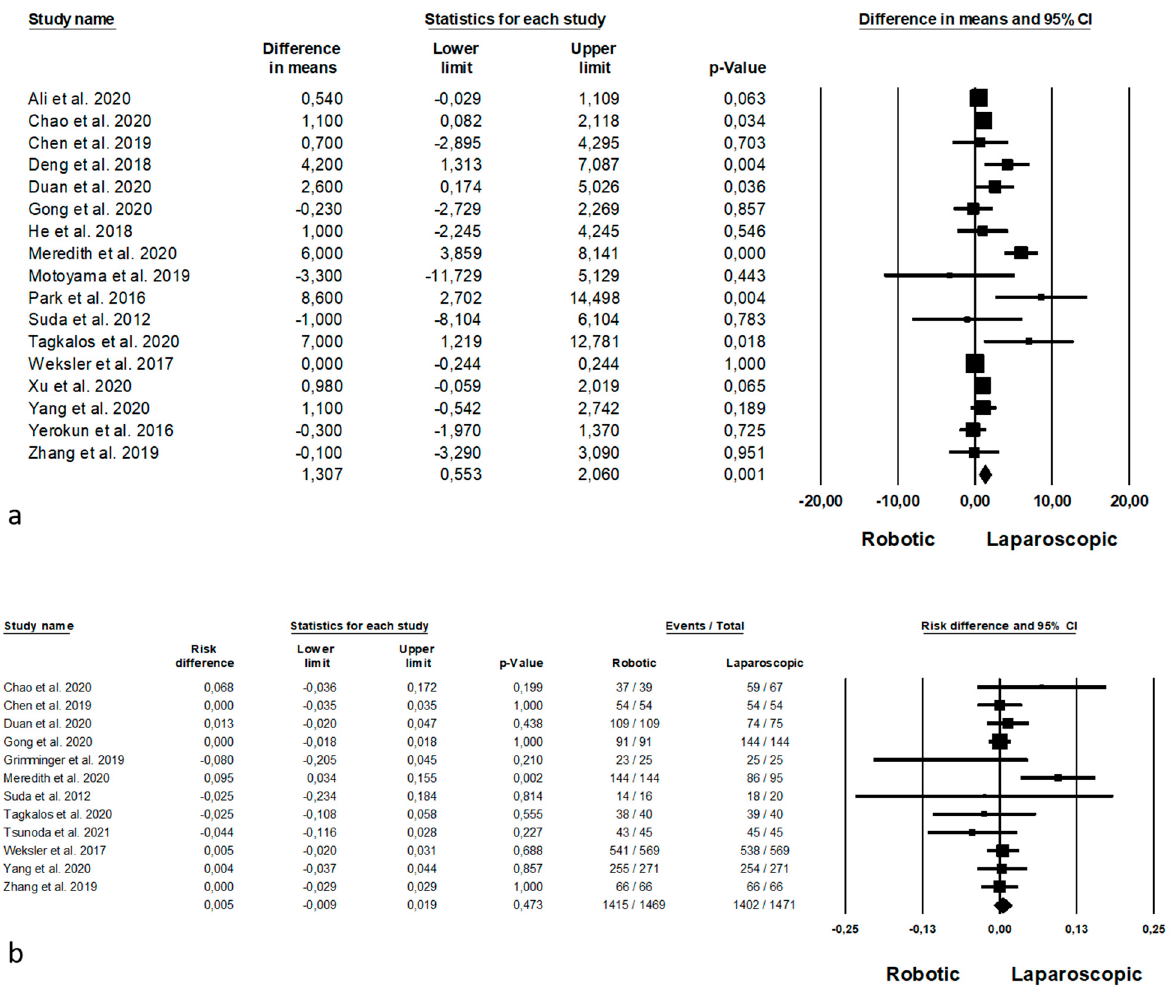
Figure 4. Robotic versus laparoscopic surgery: oncologic outcomes. ( a ) Number of harvested nodes; ( b ) R0 resection. Length of hospital stay was represented in Figure 5. This data was reported by 16 Authors [20–23,28,36–38,41,43,45,46,48,50,51,54], on 9642 patients (2713 robotic and 6749 = 0.289, 95%CI − 1.241; 0.289), with a signi fi cant heterogeneity among the studies (I 2 = 72.303%, p < 0.0001).